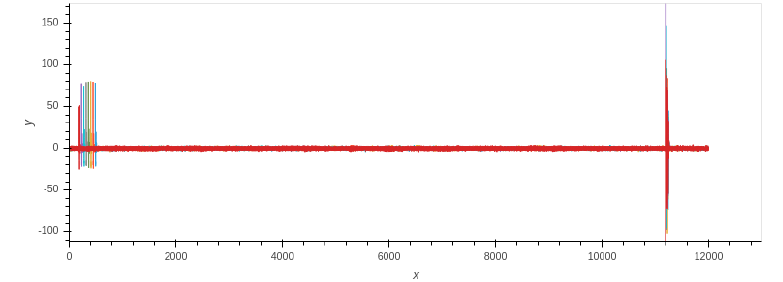
Figure 8: The t-test results for the first byte of the share m ⊕ r .